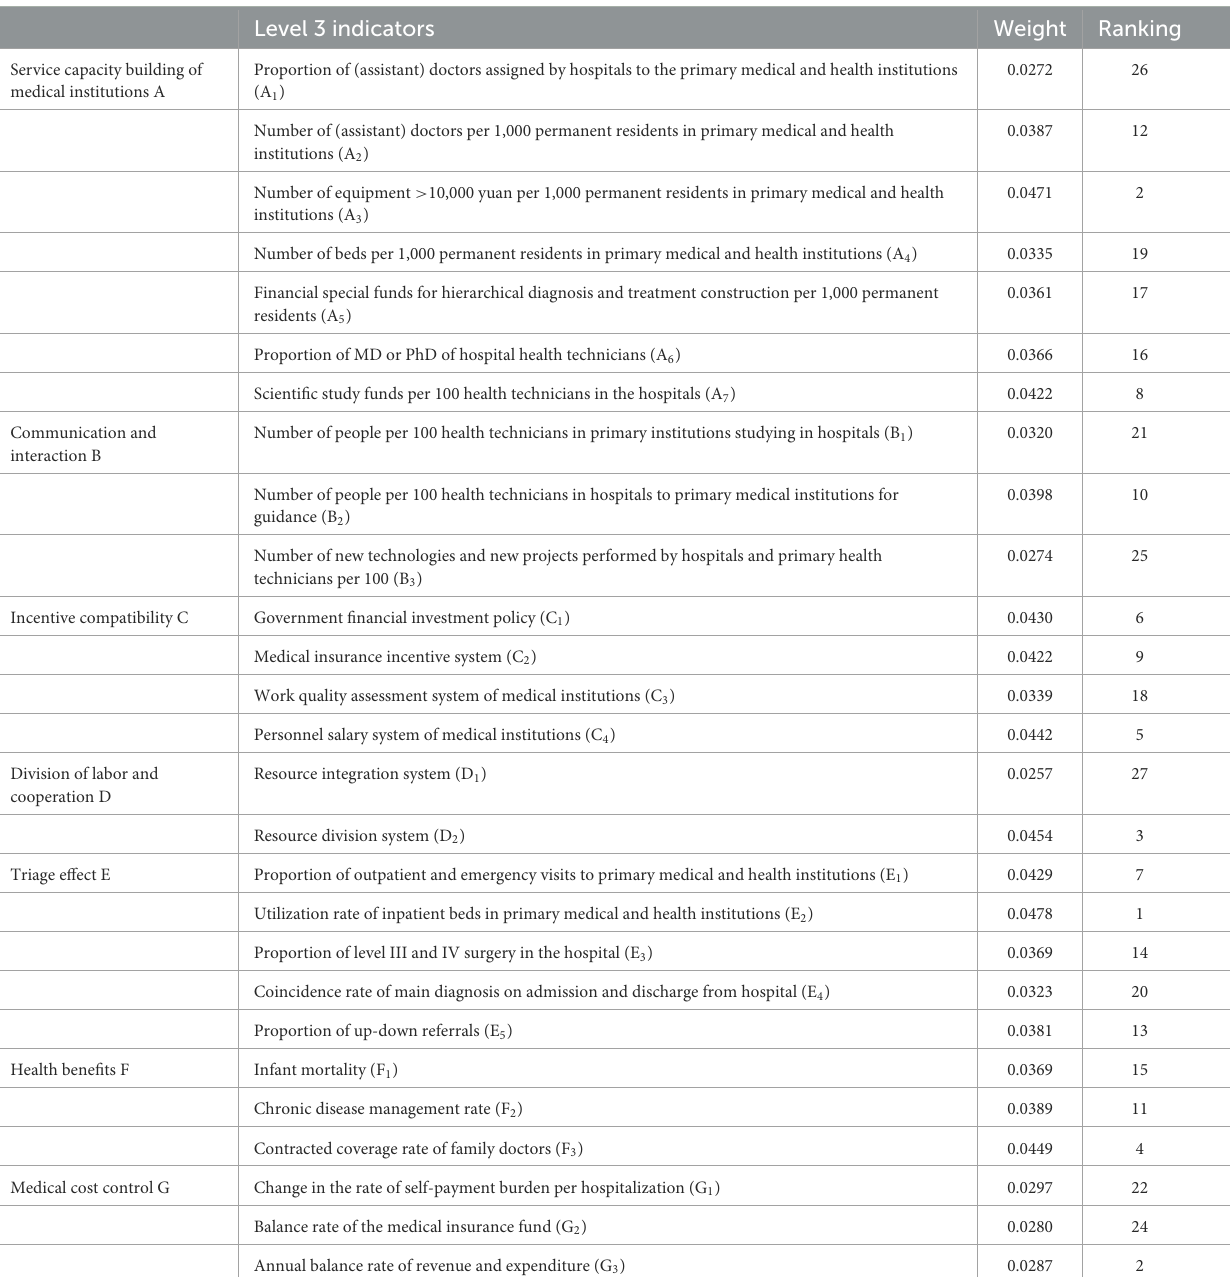
TABLE 2 Weight value and ranking of the performance evaluation indicator system of the hierarchical diagnosis and treatment